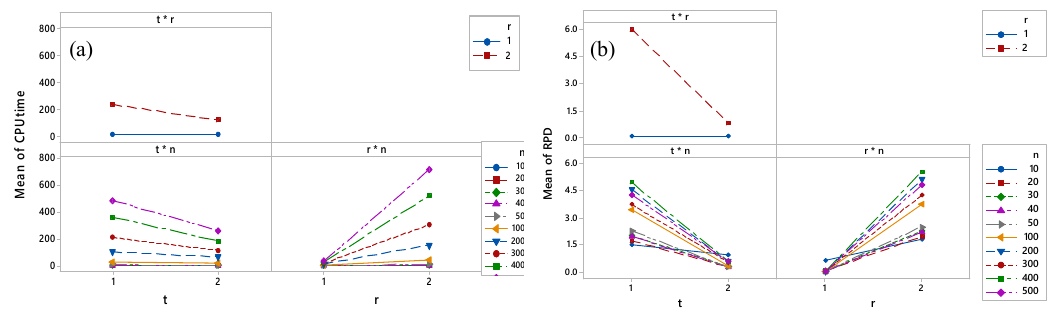
Figure 5. Interaction plots for ( a ) the CPU time and ( b ) RPD.